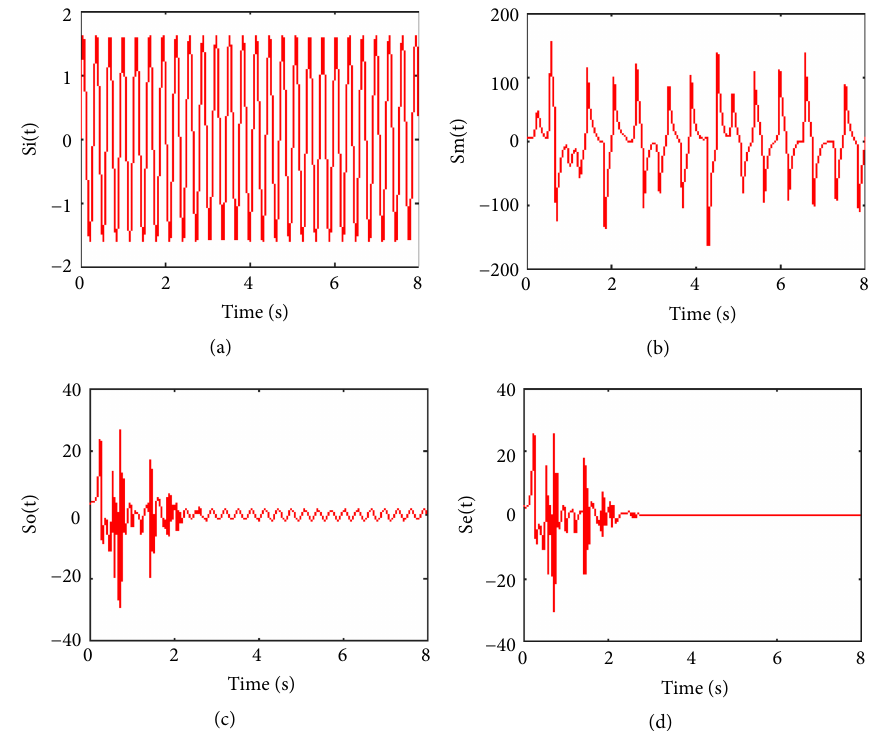
sin (𝑡) = 1.6 (20𝑡) , (b) the encrypted signal 𝑠 𝑖